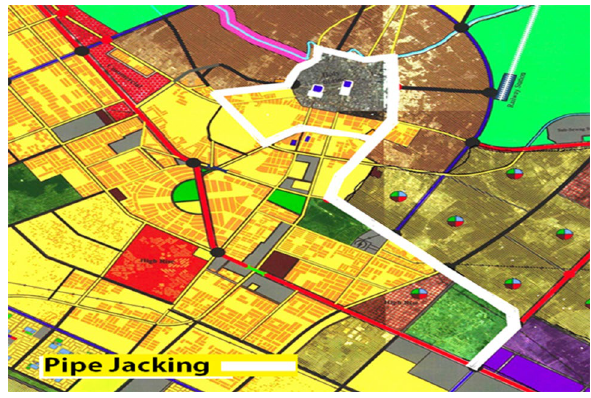
Fig. 7 Suggested sewer line (SSL) of the Karbala city center by